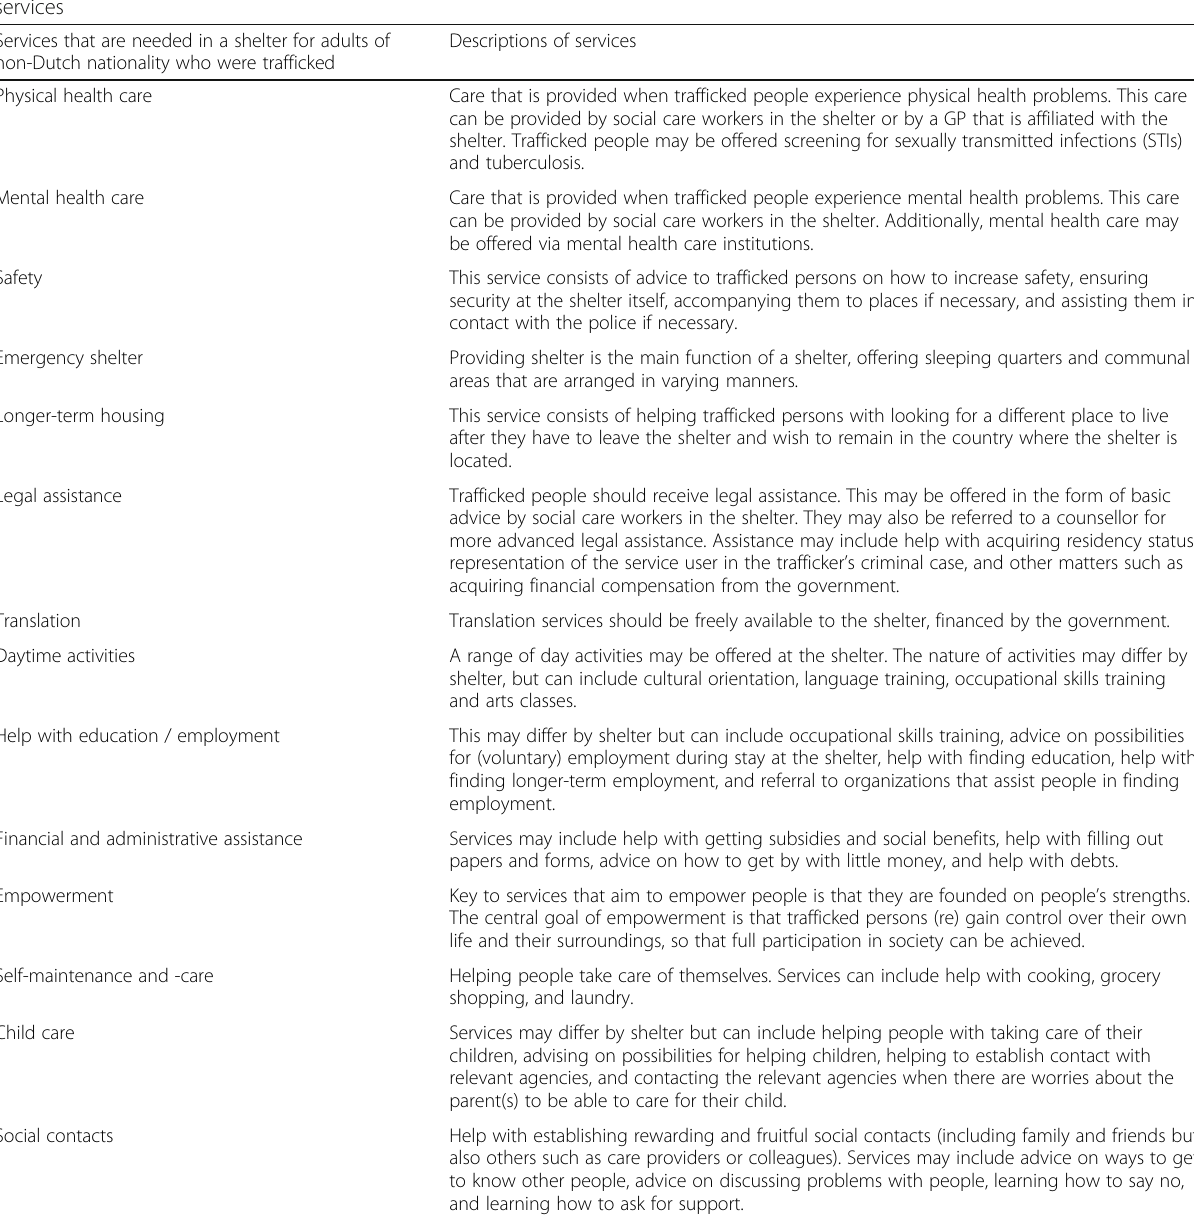
Table 1 Needs for services in a Dutch shelter for adults of non-Dutch nationality who were trafficked and descriptions of those services Services that are needed in a shelter for adults of non-Dutch nationality who were